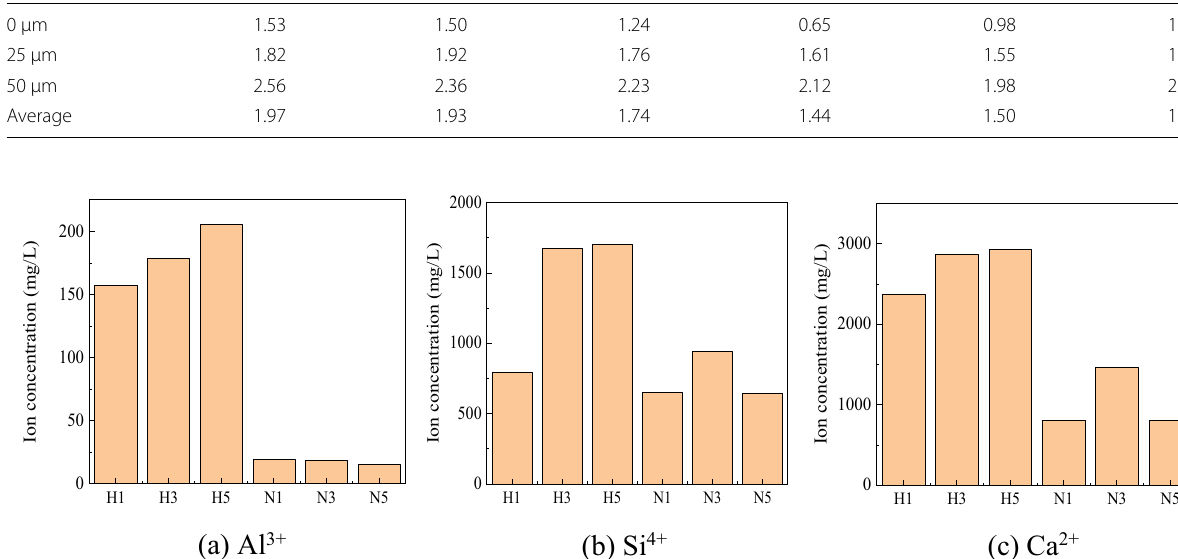
Fig. 8 Ion release concentration of iron tailings in different activated solutions